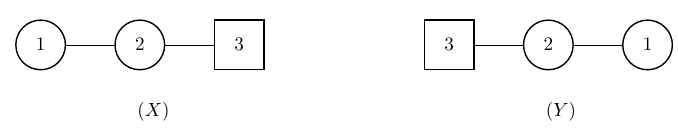
Figure 15 . The starting point for the S -type operation construction is the self-dual theory T (U(3)) .